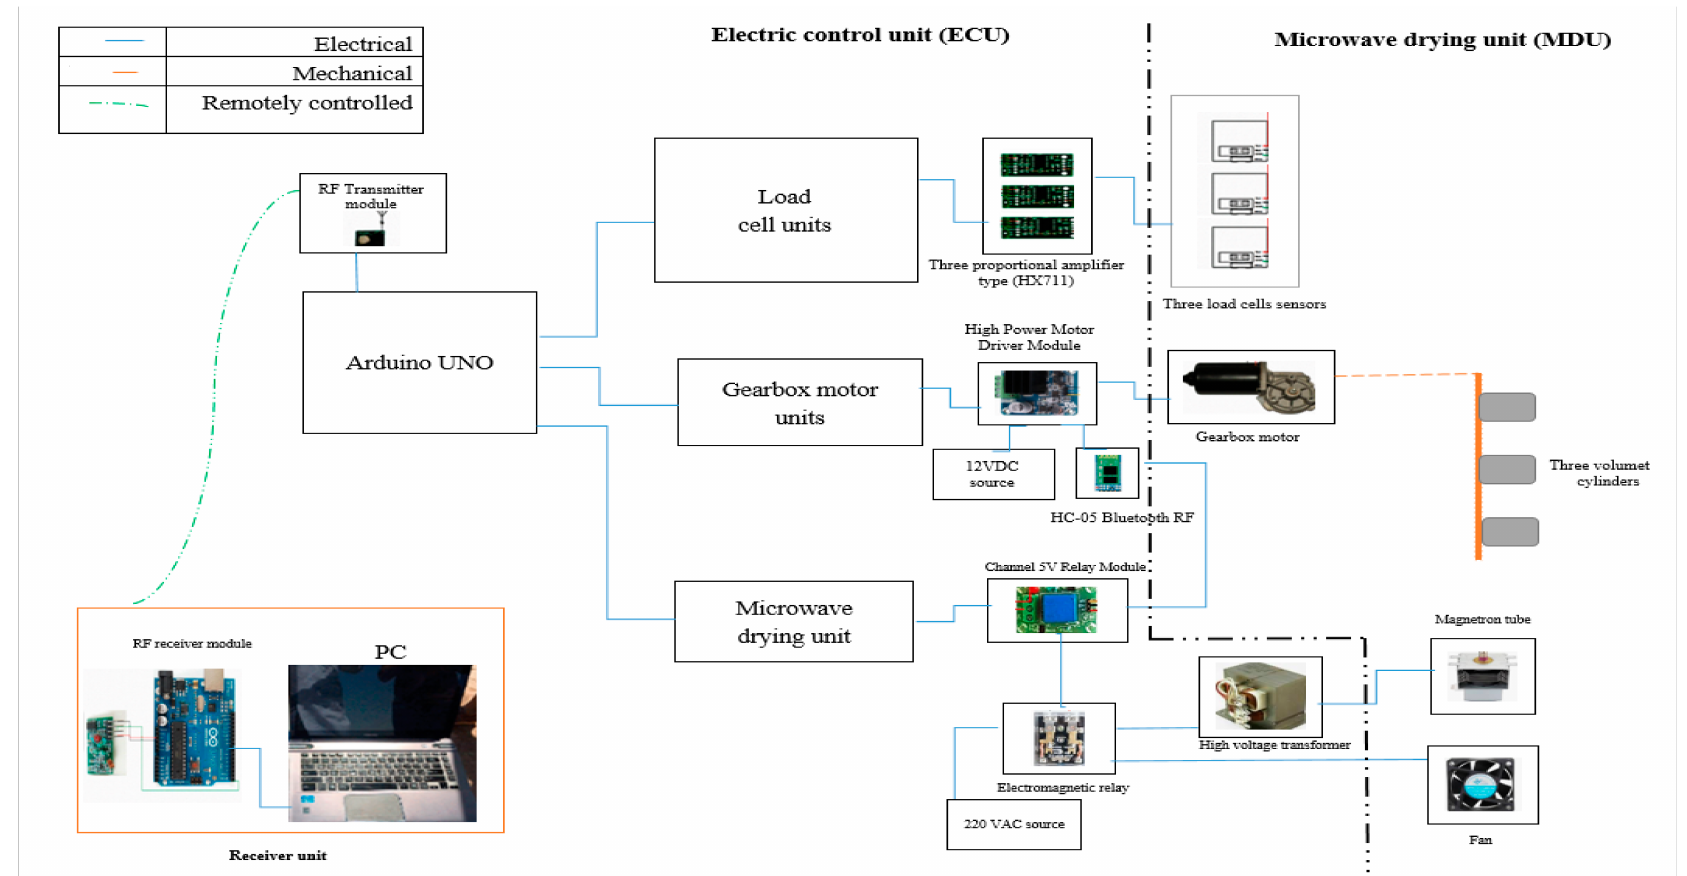
Figure 3. Block diagram displays the components of the digital electromechanical system